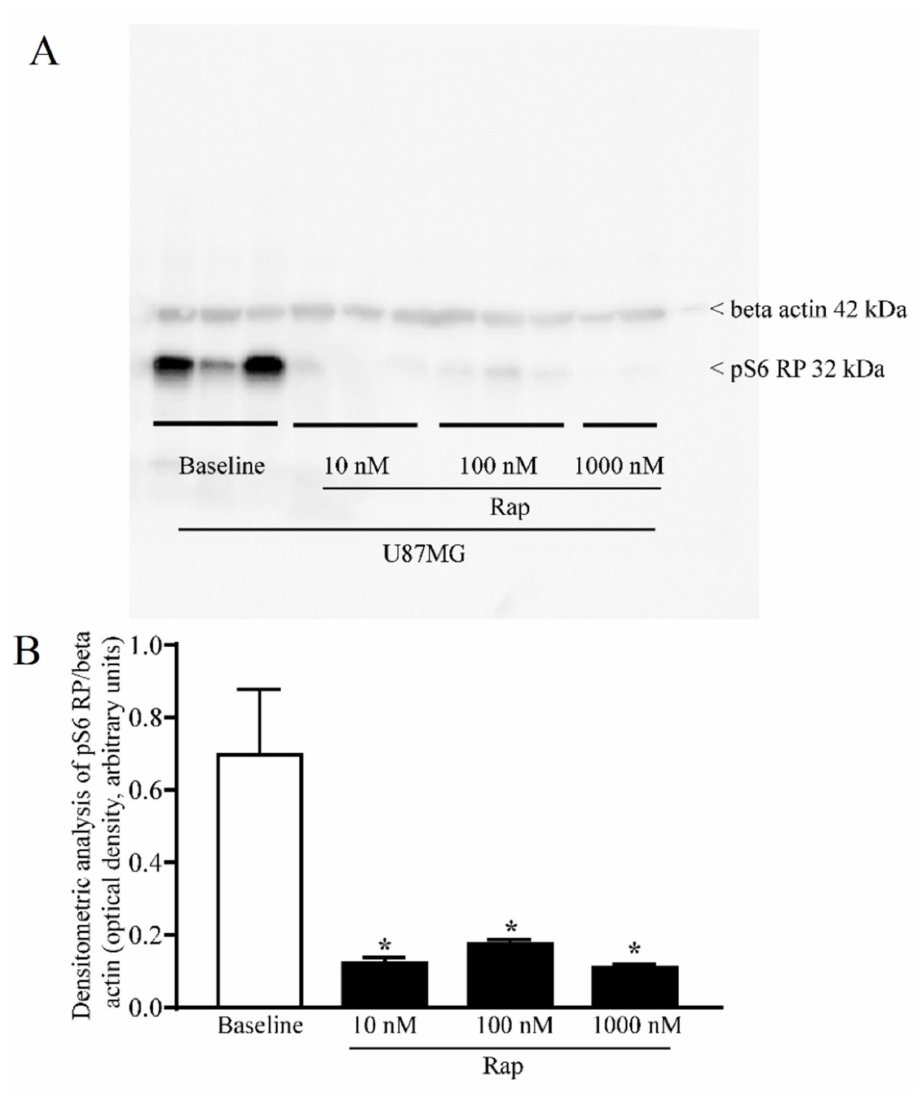
Figure 4. Rapamycin dose-dependently reduced the pS6 ribosomal protein assessed by immunoblot- ting. ( A ) Representative immunoblotting for the ribosomal protein pS6 (pS6 RP) and the housekeeping protein β -actin in U87MG cells, in baseline conditions and following rapamycin exposure. ( B ) The ratio between the optical densities of pS6RP and β -actin. Data are given as the mean ± SEM of the optical density referring to n = 6 (baseline, 10 nM, 100 nM) and n = 4 (1000 nM) samples from different cultures obtained in N = 2 experiments. * p < 0.05 compared with